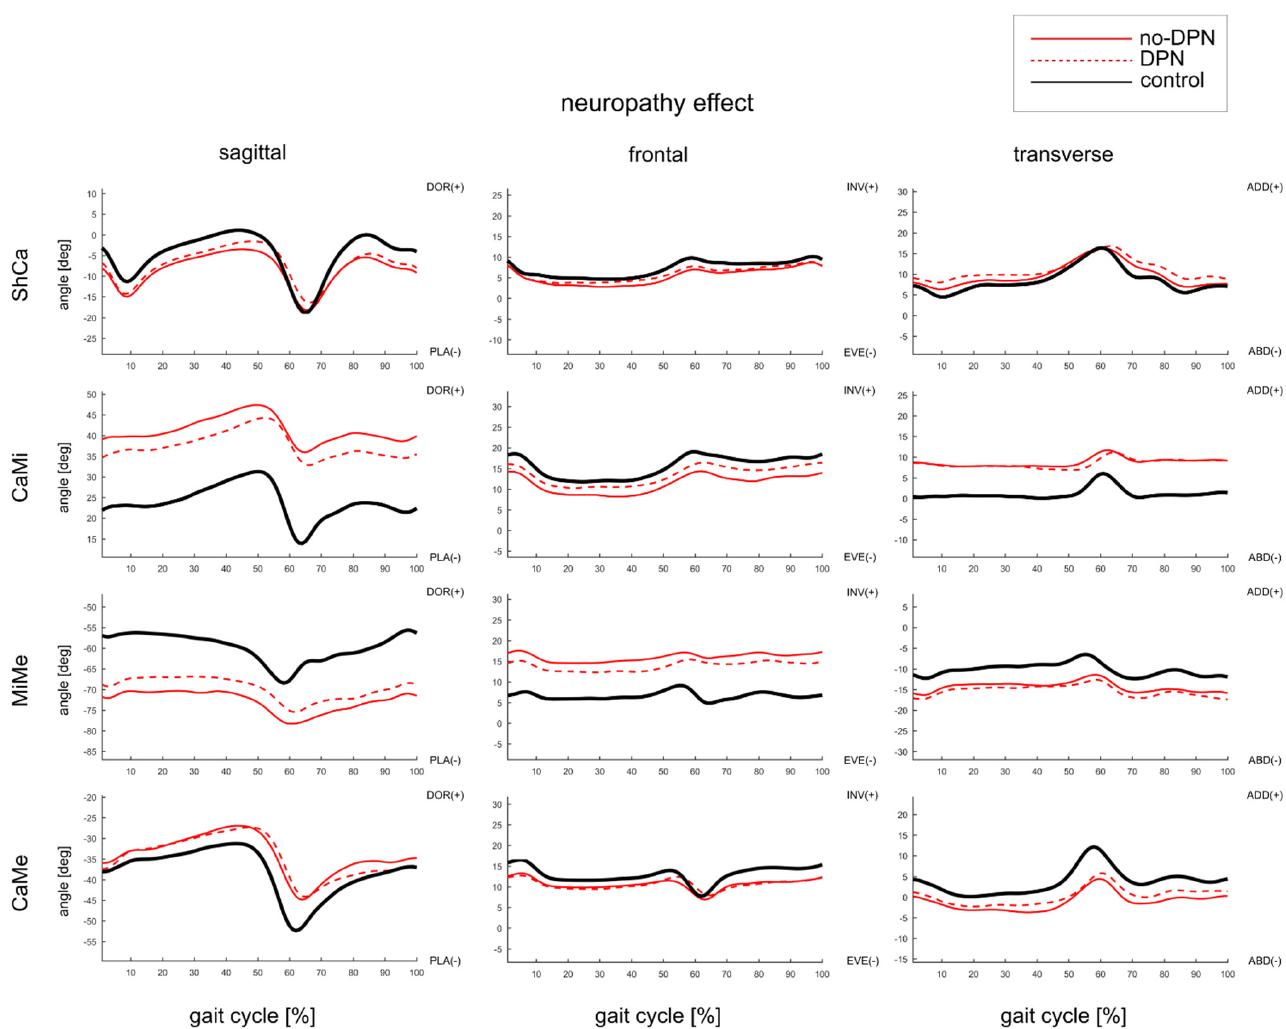
Figure 4. Mean temporal profiles of foot joint rotations [deg] normalized to gait cycle duration across all trials of neuropathic (DPN, continuous red line), non-neuropathic (non-DPN, dashed red line) and control subjects (continuous black line). Top to bottom, rotation in the three anatomical planes between calcaneus and shank (ShCa), midfoot and calcaneus (CaMi), metatarsus and midfoot (MiMe) and metatarsus and calcaneus (CaMe). Left to right, rotations in the sagittal, frontal and transverse planes according to the axes of each joint coordinate system.